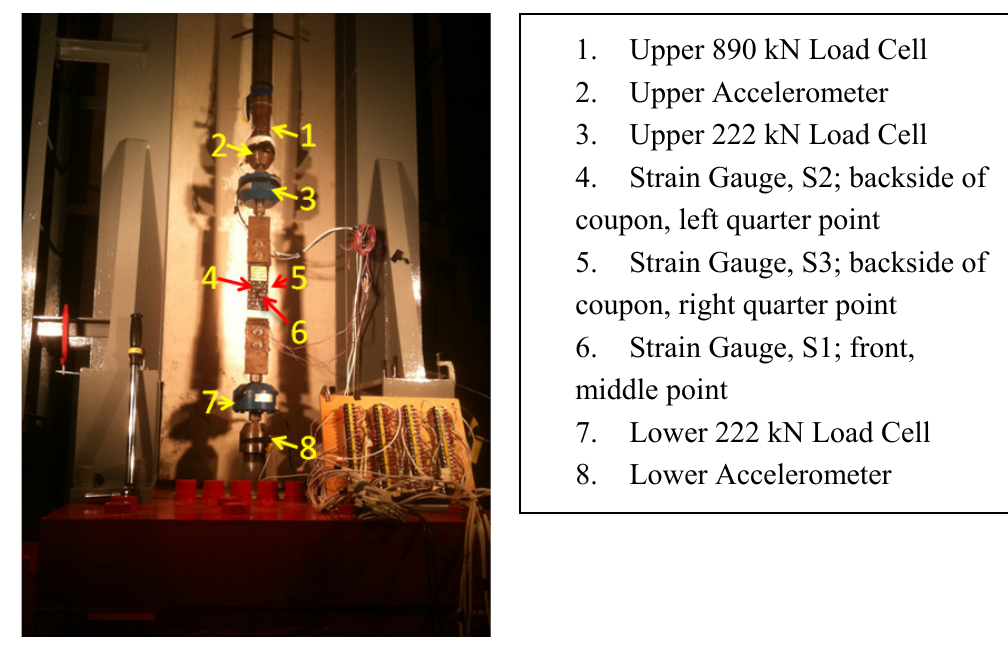
Figure 5. CFRP coupon in dynamic loader.